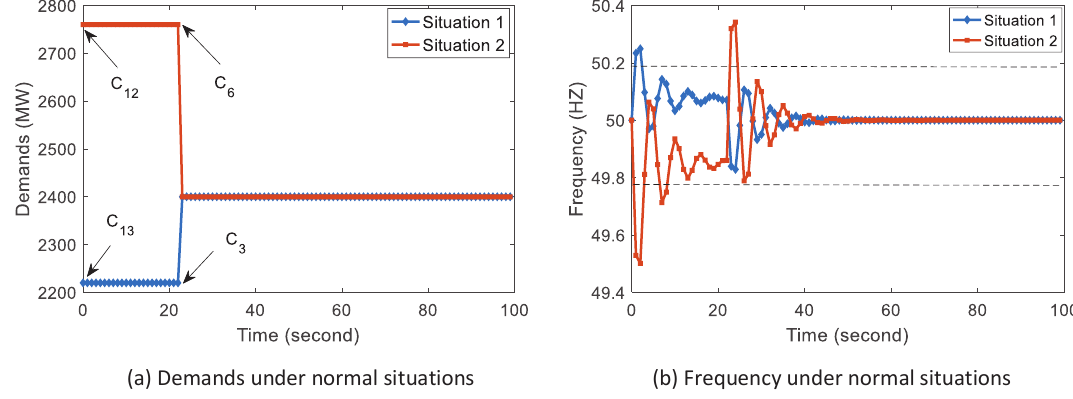
Figure 5. Measurements under normal